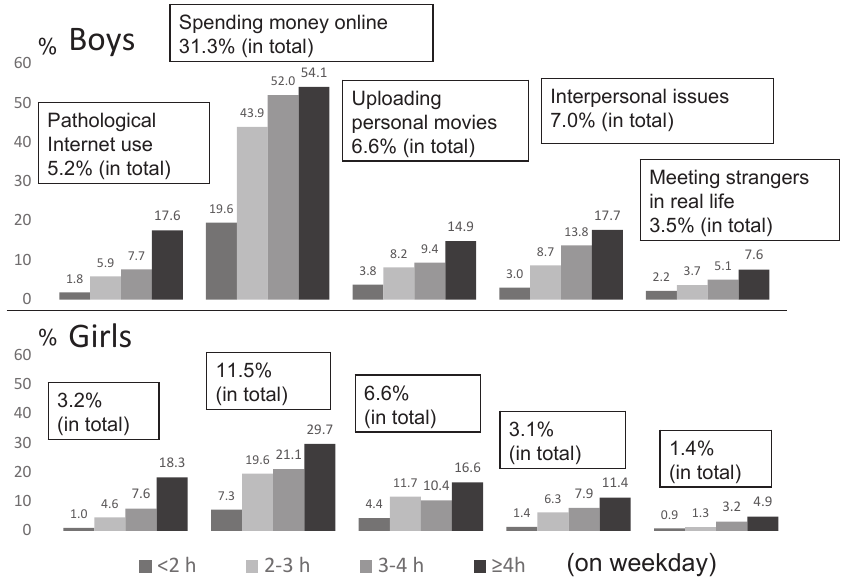
Figure 2. Prevalence of pathological Internet use and risky behaviors by sex. Similar trends were seen between boys and girls. However, spending money online was much prevalent in boys, especially for those using the Internet for more than 2 hours. Notably, 1.4% of girls had met strangers encountered online in real